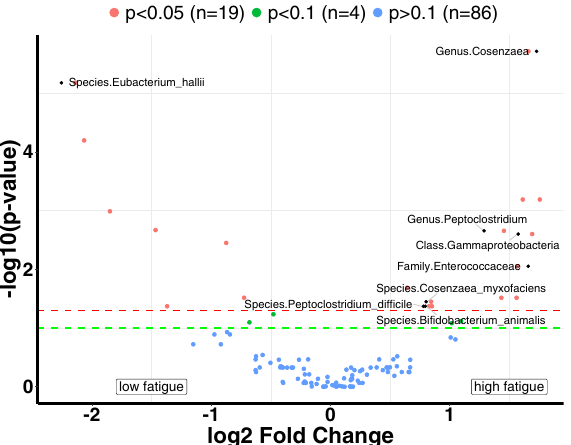
Figure 3. Volcano plot showing that, of 109 taxonomic features, 19 were significantly differential between low- and high-fatigue groups (p < 0.05; DESeq test with Benjamini–Hochberg procedure to adjust the p-values). Eight features identified by DESeq agree with the ones identified by our method. They were annotated with text names in the plot. The blue dot represents the features whose p-values are greater than 0.1; the green dot represents the features whose p-values are less than 0.1 and greater than 0.05; the red dot represents the features whose p-value are less than 0.05. A positive effect size indicates that the microbial feature is more abundant in high-fatigue group.